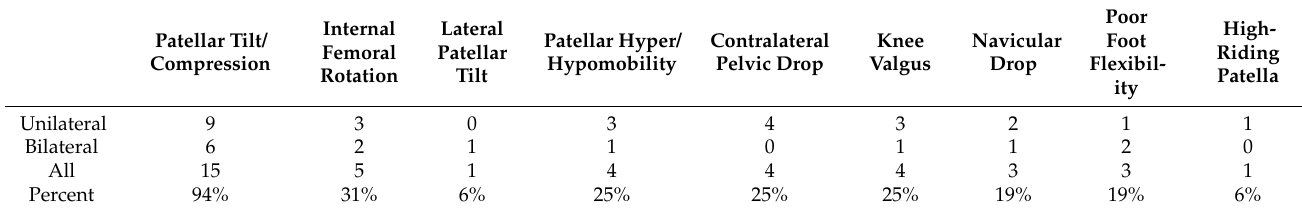
Table 2. Clinical presentation of the participants in the patellofemoral pain group.